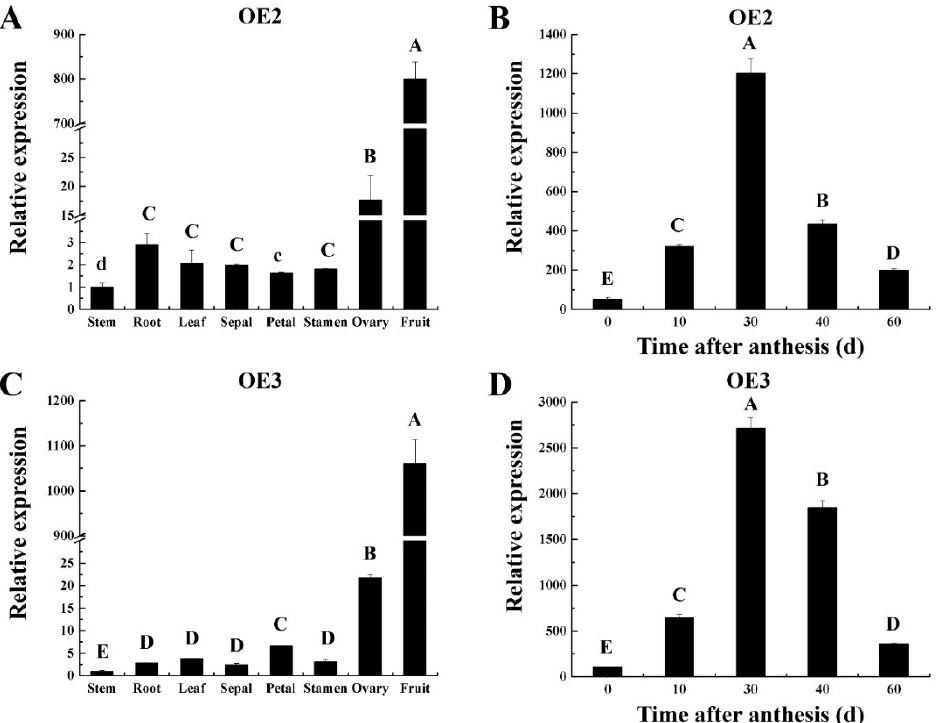
Figure 2. Temporospatial analysis of CsSUN expression in transgenic tomato lines by qRT-PCR. ( A , C ) CsSUN expression in different tissues from two transgenic tomato lines OE2 ( A ) and OE3 ( C ). ( B , D ) CsSUN expression in the fruits from OE2 ( B ) and OE3 ( D ) at different developmental stages. Data are displayed as mean ± standard deviation of three biological repeats. Different capital and lower letters indicate significant differences at the statistical levels of 0.01 and 0.05, respectively (unpaired two-tailed t -test).